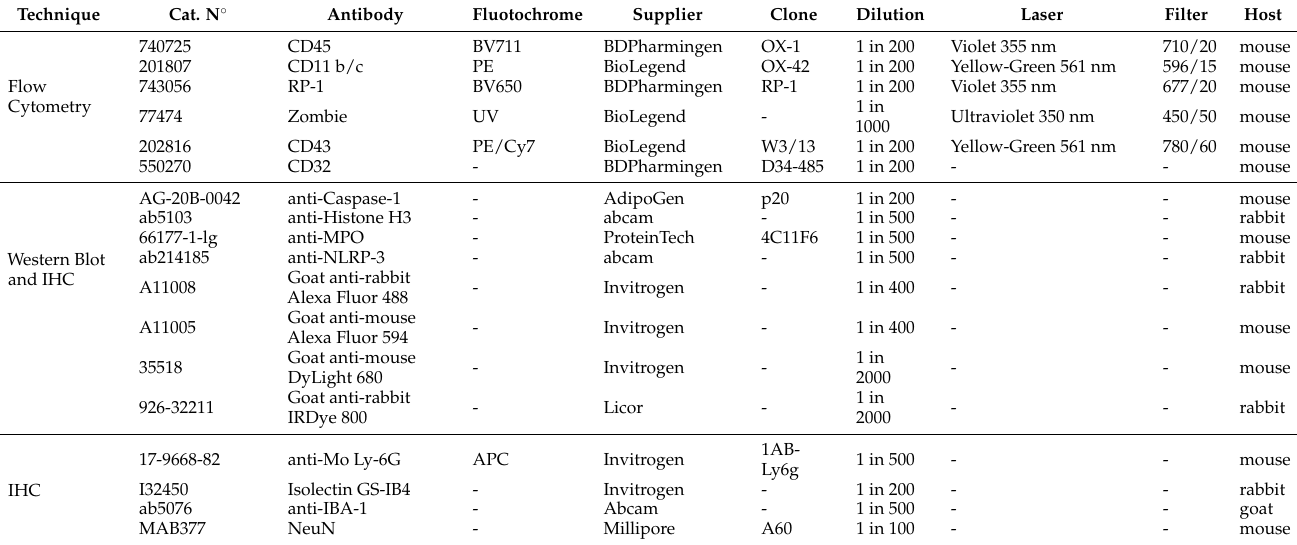
Table 1. Antibodies list used for flow cytometry, immunohistochemistry and biochemistry.